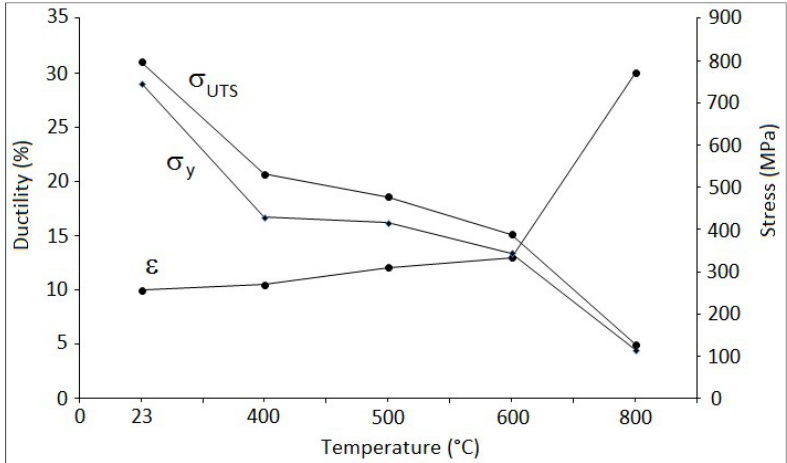
Figure 14. Ultimate tensile strength, yield strength, and ductility behavior vs. temperature measured on specimens A.